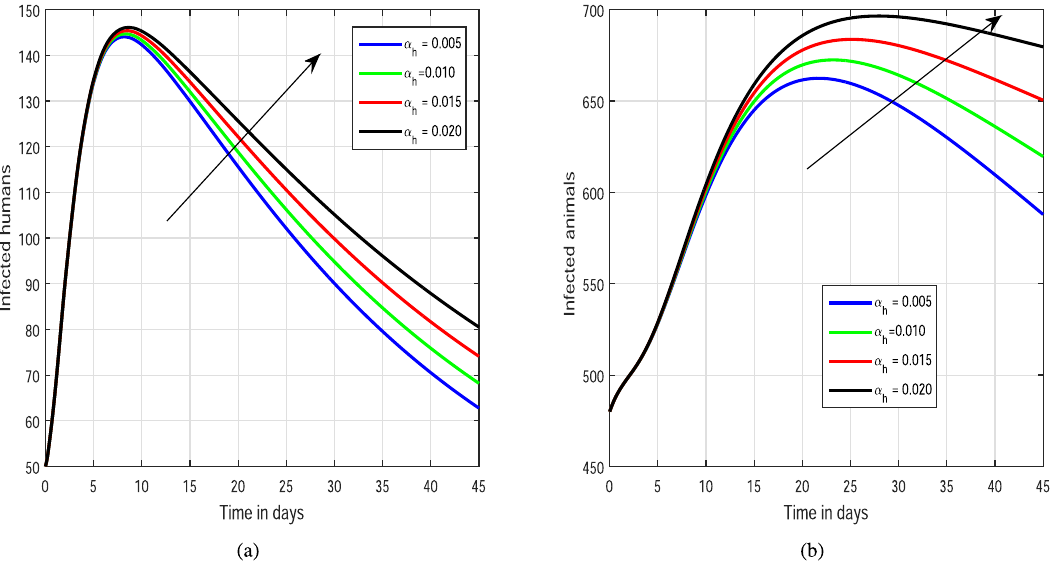
Figure 6: Graphical view analysis of the dynamical behaviour of the fractional model ( 9 ) of zoonotic infection with variation of α h , i.e. = α 0.005, 0.010, 0.015 h , and